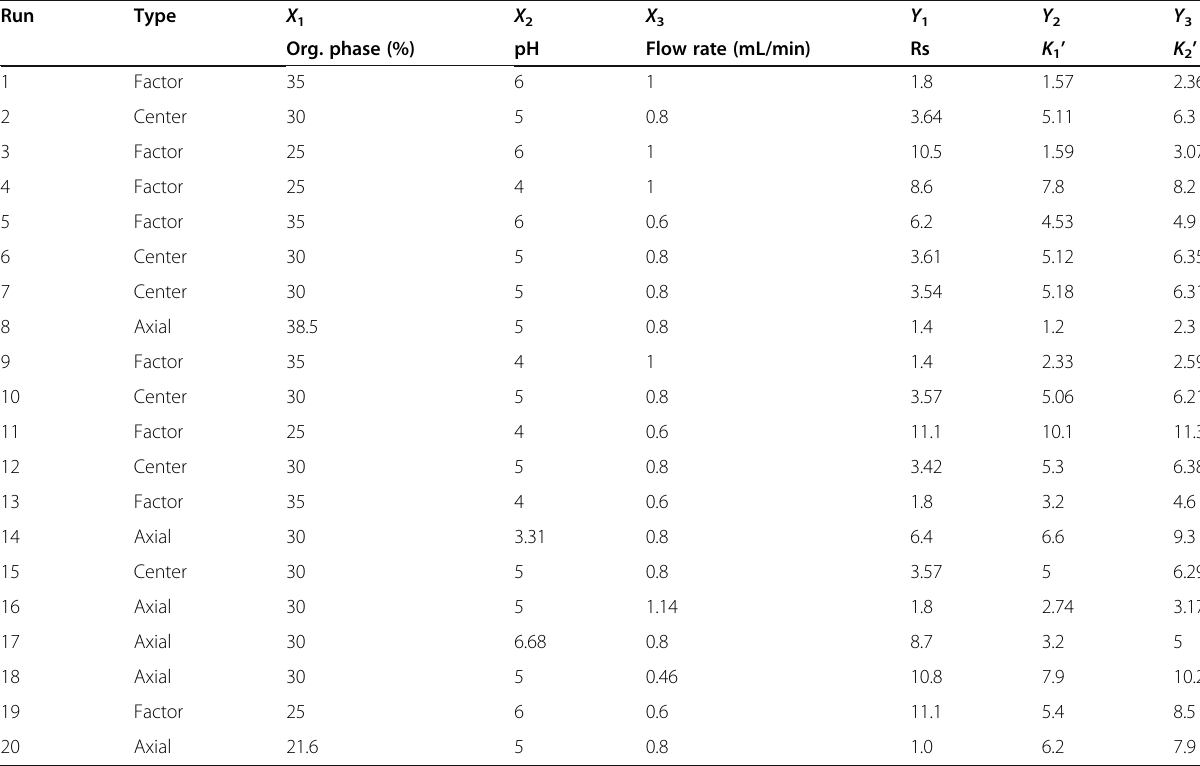
Table 1 Central composite design and experimental results